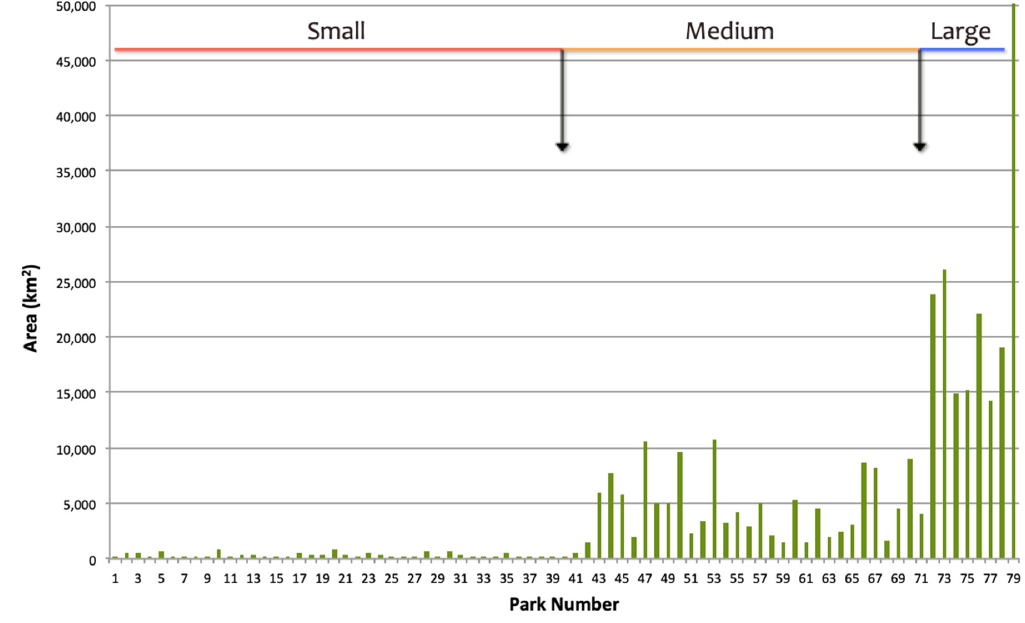
Figure 2. National parks used in the study by area, showing the breakdown of the three size area classes: small, medium, and